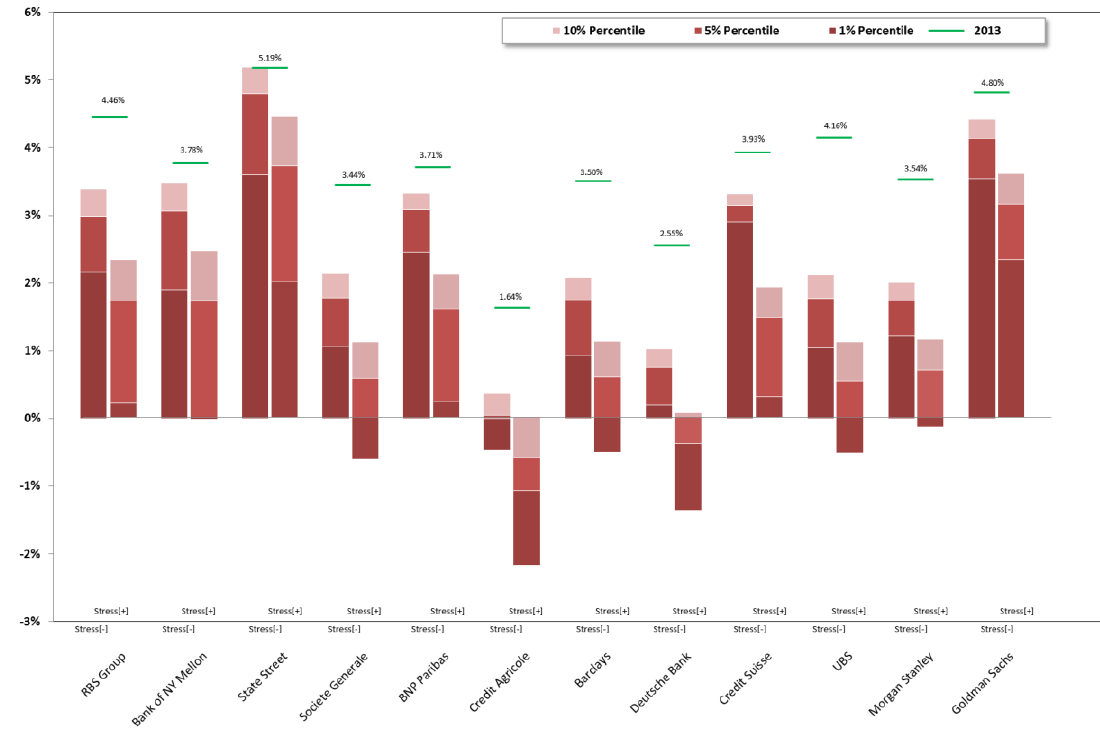
Figure 5. Stressed leverage ratio 2015 vs. leverage 2013. IB & IBU.